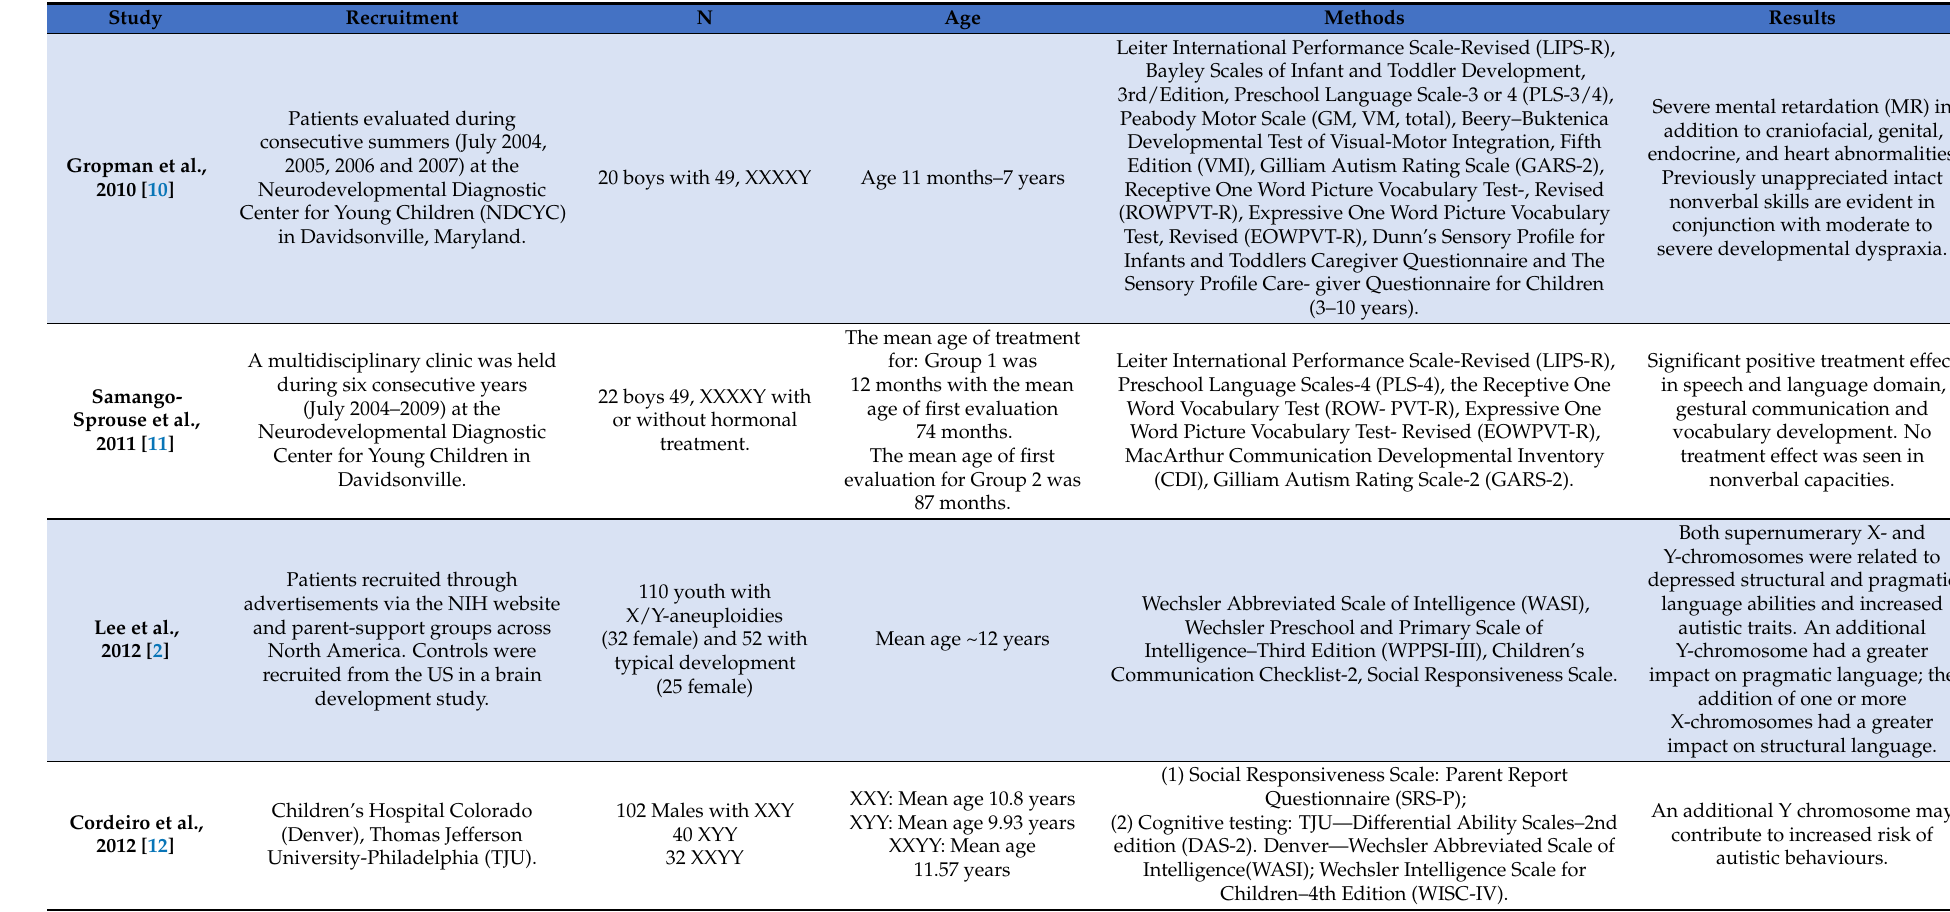
Table 2. Articles